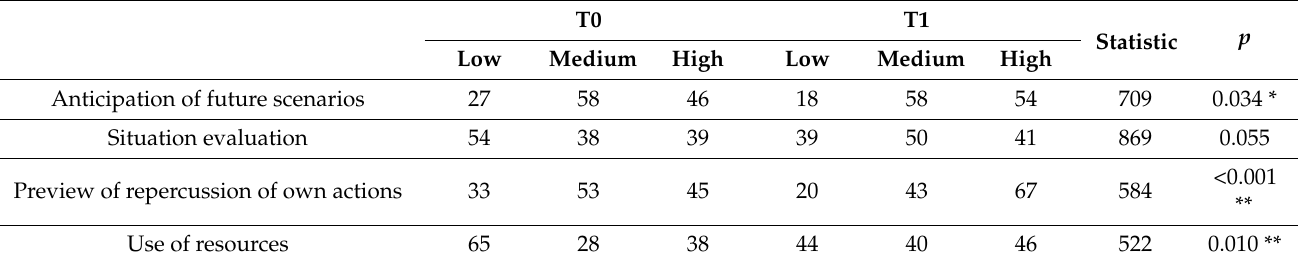
Table 4. Comparison of level of competences before and after the nine-month intervention.